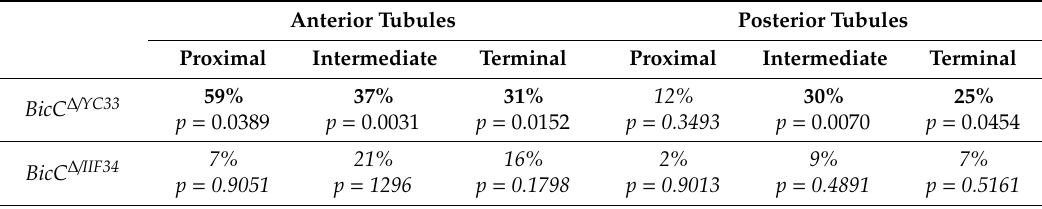
Figure 2. Melatonin reduced cysts in the renal tubule of BicC ∆ / YC33 flies. ( a ) Representative Malpighian tubules micro-dissected from BicC ∆ / YC33 flies treated with either vehicle (ethanol) or 150 µ M melatonin were photographed ex vivo. Arrows indicate exemplary cysts. ( b ) Nested plots reporting overall number of cysts found in each anterior and posterior tubule pair of 50 vehicle- and 50 melatonin-treated cystic flies, with mean and standard deviation. ( c ) Regional analyses. Nested plots indicating the number of cysts found in the proximal, intermediate, and terminal region of the anterior and posterior tubule pairs of the flies in b, with mean and standard deviation. p values (with Welch’s correction) are indicated. Treatments are shown with color: vehicle, left, grey; melatonin, right, green. Melatonin treatment significantly reduced cysts in all regions of the Malpighian tubules of BicC ∆ / YC33 flies ( p < 0.05), except for the proximal region in the posterior tubules. Table 2. Regional cyst reduction upon melatonin treatment of BicC